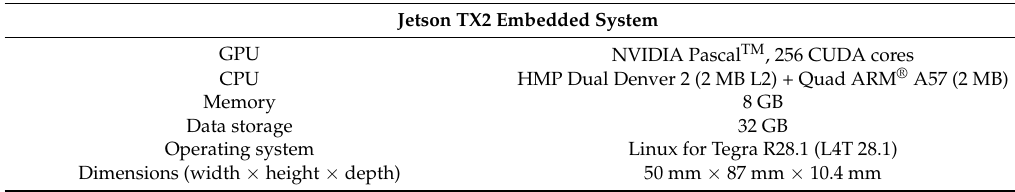
Figure 16. Jetson TX2 embedded system. Table 10. Specifications of the Jetson TX2 embedded